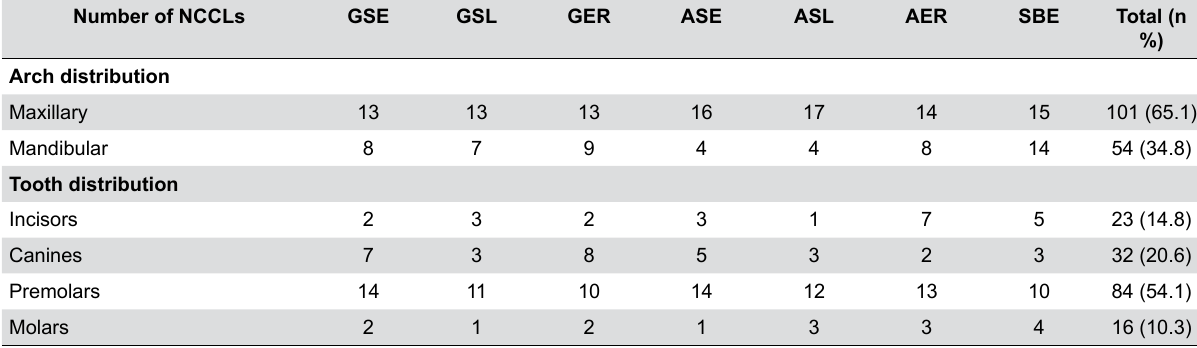
Table 2- Distribution of non-cervical caries lesions (NCCLs) according to tooth type and